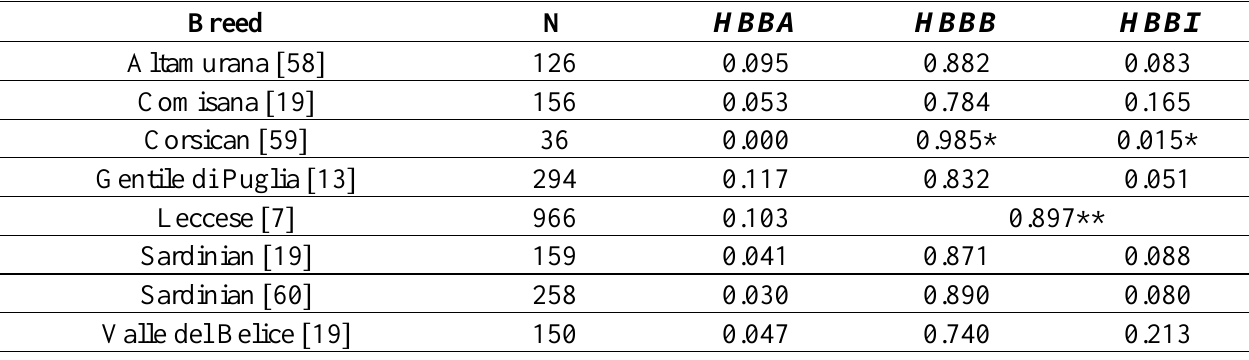
Table 8. Frequency of HBB alleles in southern Italian and Mediterranean islander sheep breeds as reported in the